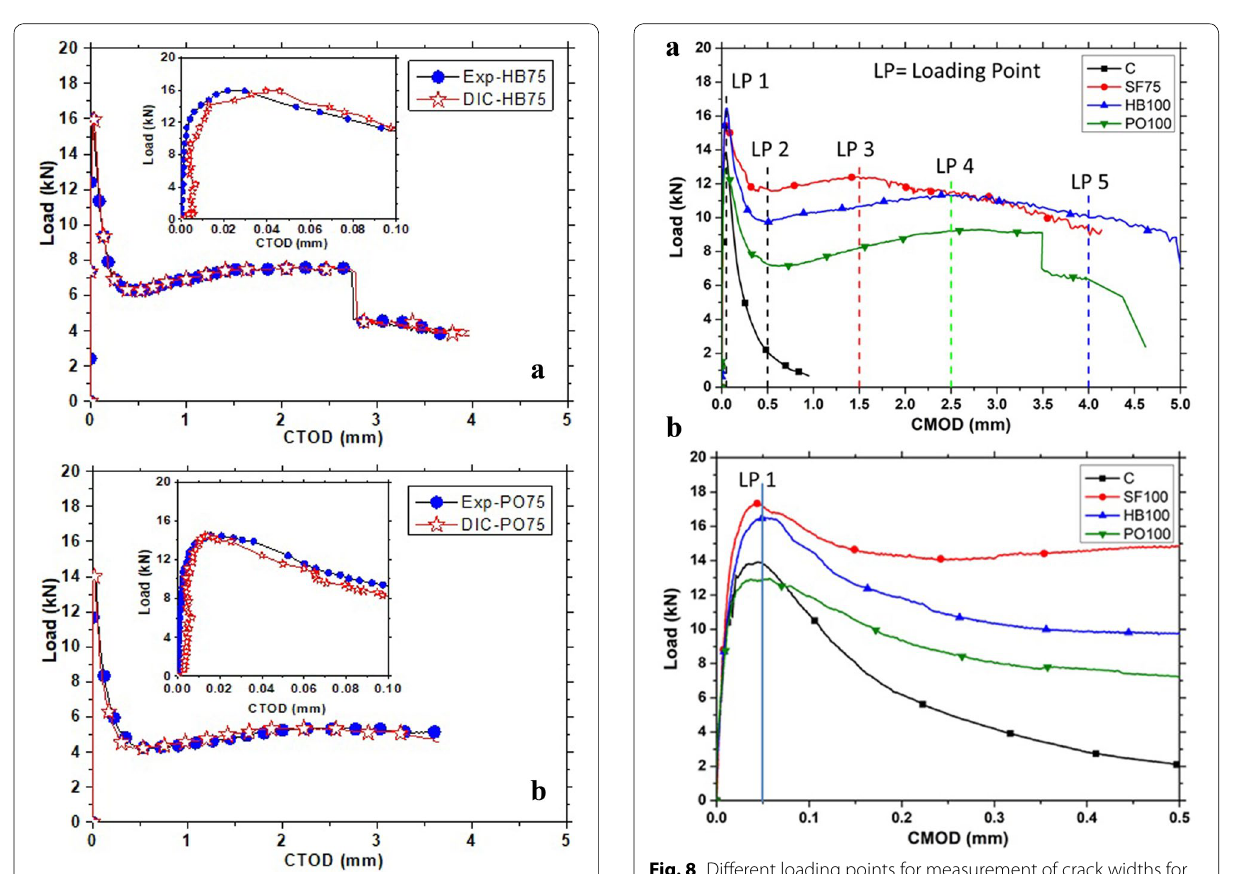
Fig. 8 Different loading points for measurement of crack widths for comparison: a up to 5 mm CMOD; b up to 0.5 mm